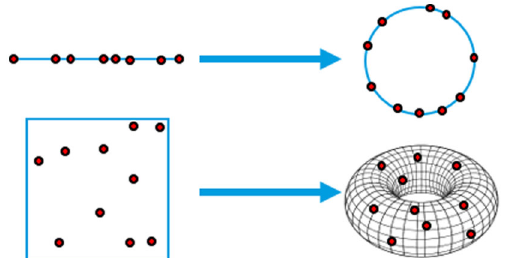
FIG. 4. Sketch of how to eliminate boundary effects that preclude small- N surmises of complex spacing ratio